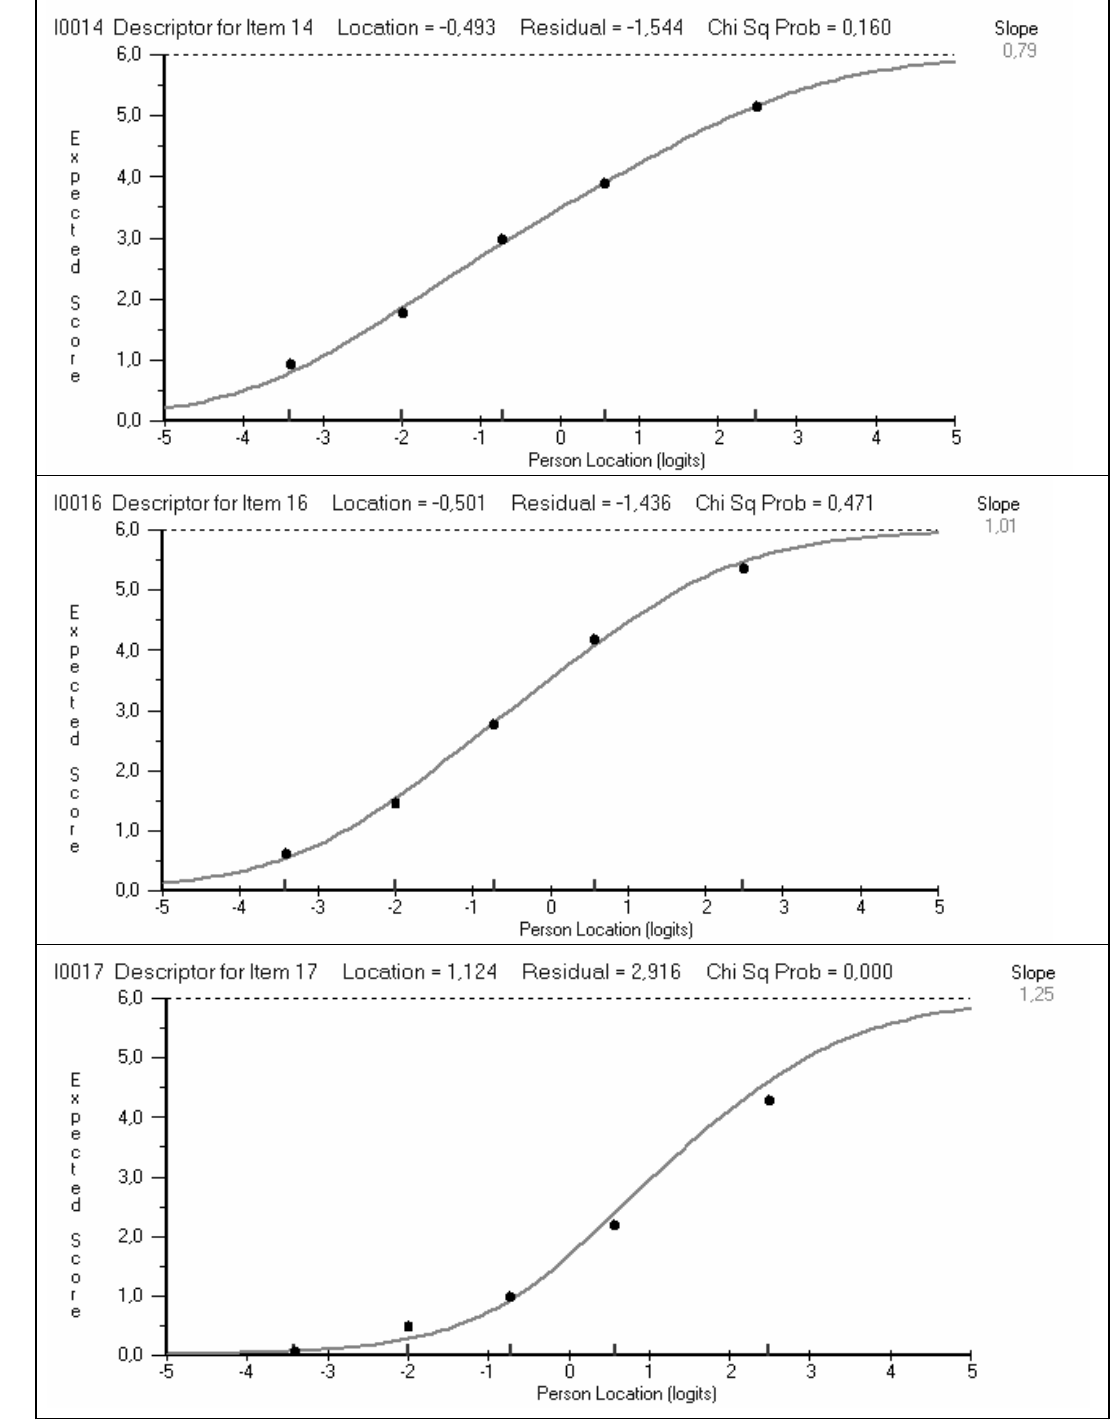
Figura 4 – Item Characteristic Curves (ICC) per gli item I0014, I0016,